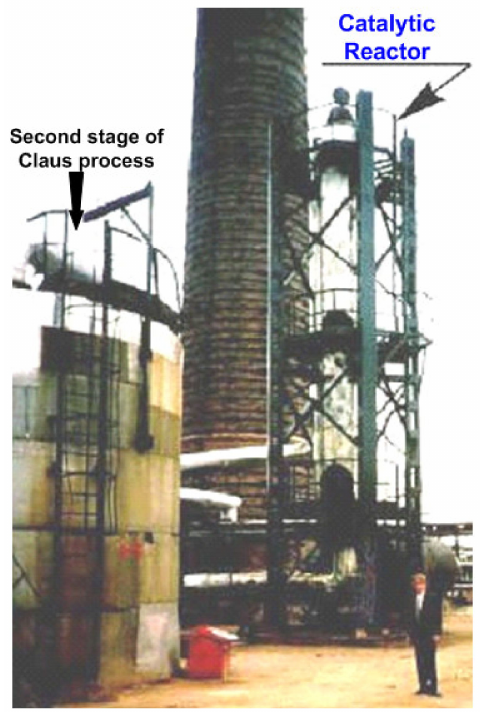
Figure 20. Semi-industrial installation for the direct oxidation of hydrogen sulfide via monolithic catalyst with a honeycomb structure. Tail-gas of the Claus